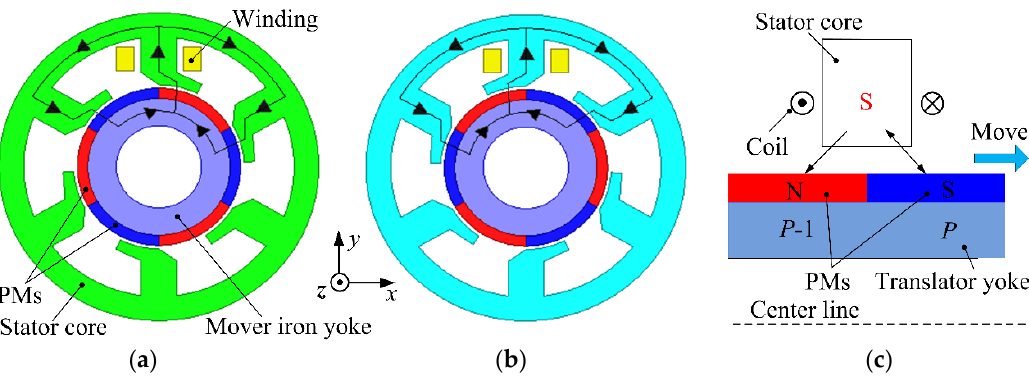
Figure 2. Magnetic flux path of STTF ‐ PMLSM: ( a ) Main flux path in P ‐ 1 pole; ( b ) Main flux path in P pole; ( c ) Side view of the STTF ‐ PMLSM. P pole; ( c ) Side view of the